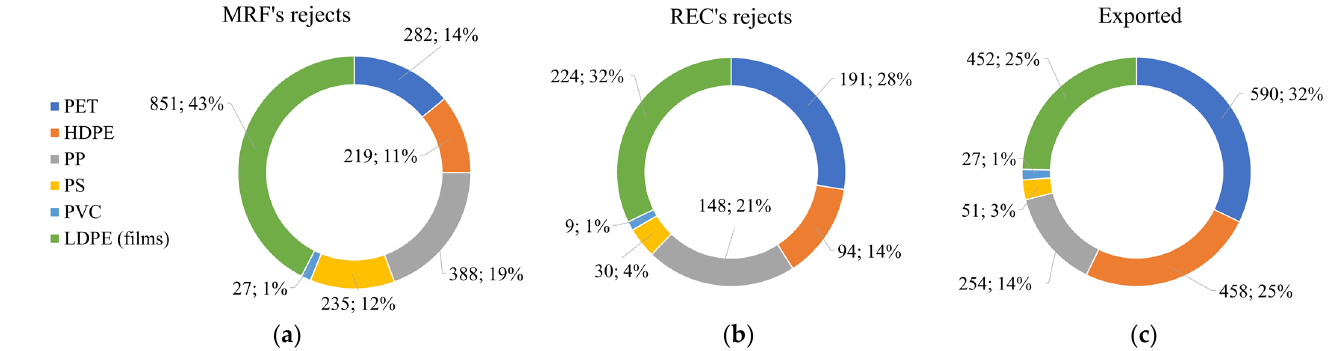
Figure 3. PPW recycling system rejects (2017): ( a ) rejects from MRFs; ( b ) rejects from RECs; ( c ) exported plastic. Values are expressed in kt y − 1 . Adapted from [62].